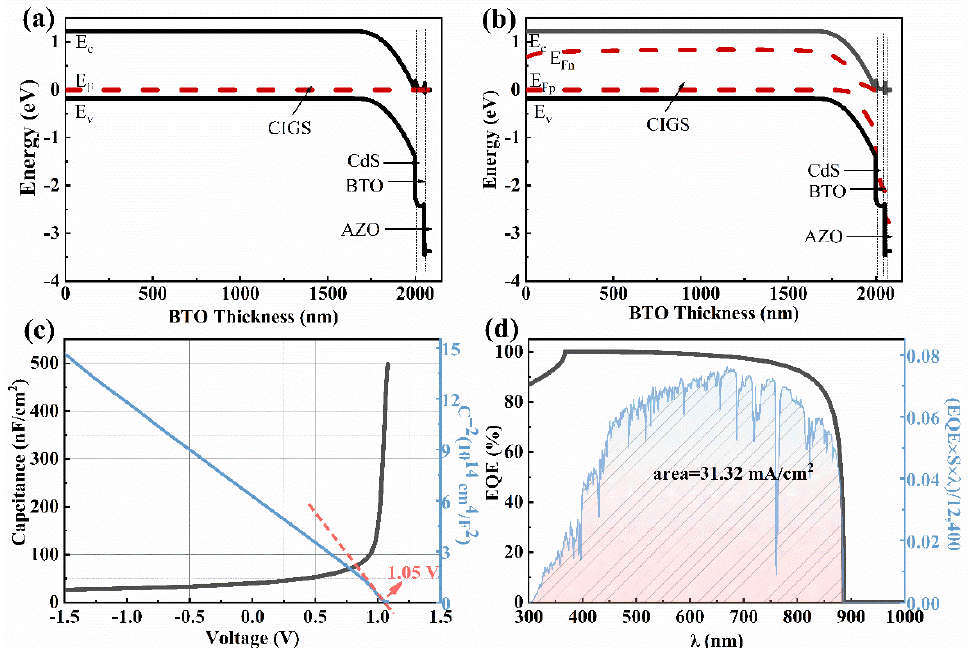
Figure 12. The energy band diagram, C - V , and EQE curves of the ferroelectric-coupled CIGS solar cell with a device structure of Mo/CIGS/CdS/BTO/AZO: ( a ) under non-light conditions, ( b ) under the AM1.5 G light illumination, ( c ) C - V and C −2 - V curves, ( d ) EQE curve and the J sc value from the integral curve based on the expression EQE × S × λ 12,400